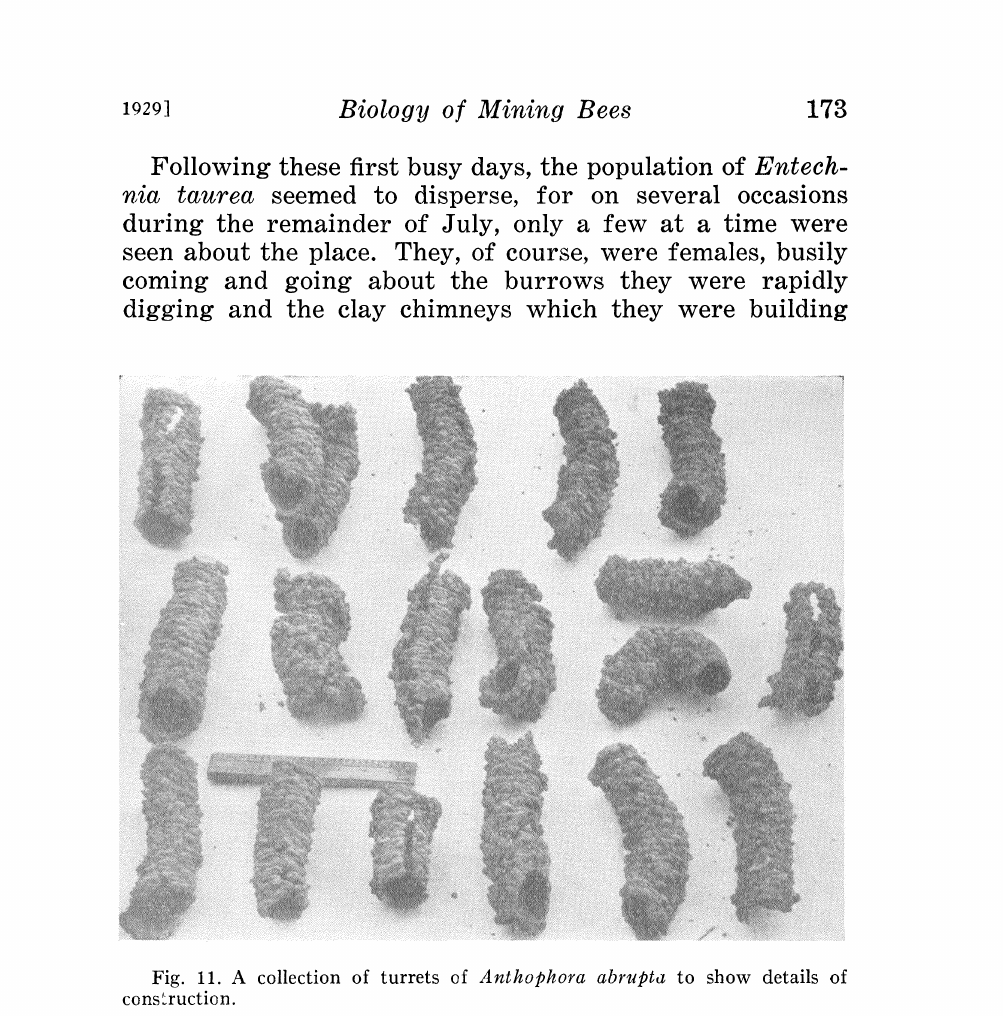
Fig. 11. A collection of turrets of Anthophora abrupta to show details of